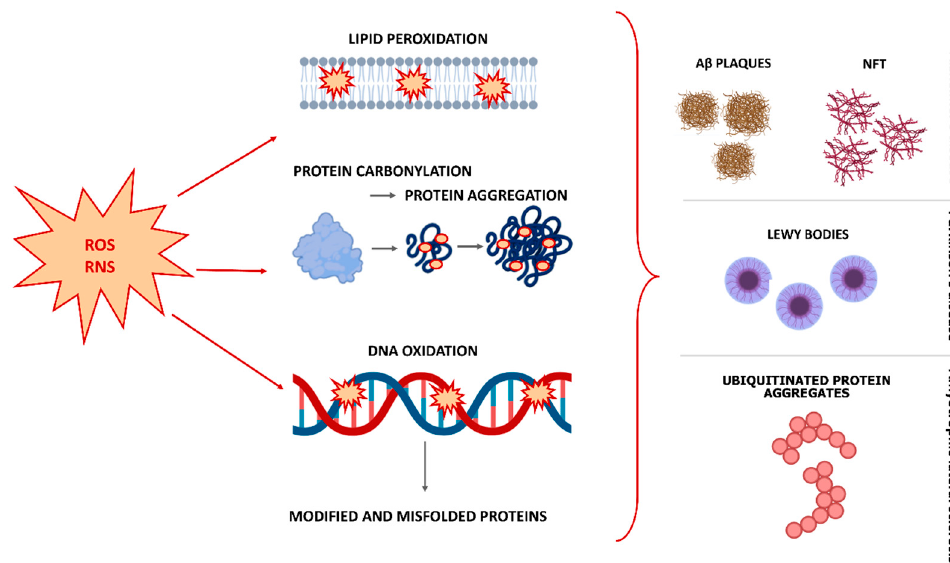
Figure 1. Effects of oxidative stress on lipids, proteins, and DNA, and generation of key pathological features in Alzheimer’s disease, Parkinson’s disease, and amyotrophic lateral sclerosis. Abbreviations: ROS, reactive oxygen species; RNS, reactive nitrogen species; A β , beta-amyloid; NFT, neurofibrillary tangles.